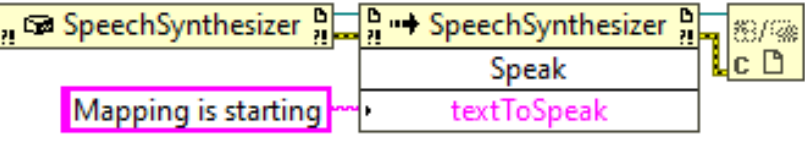
Figure 2. Algorithm that audibly announces the start of mapping.